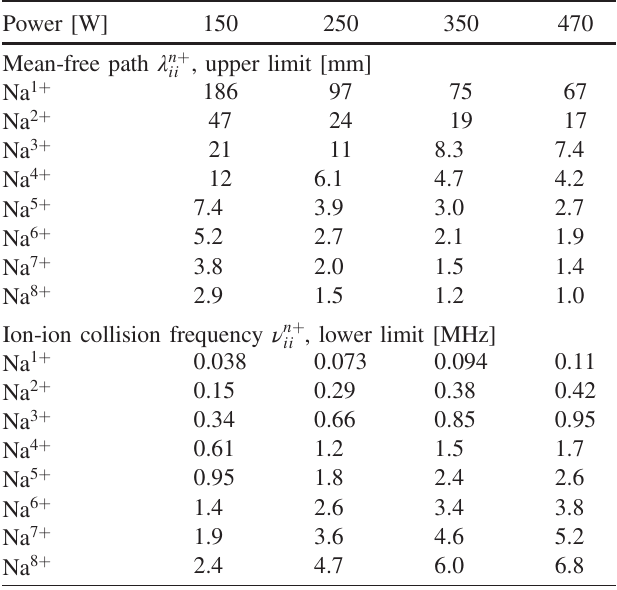
TABLE I. Breeding efficiencies (percentages) of low and high charge state 23 Na in helium plasma as a function of the micro- wave power. Δ V is optimized for Na 6 þ at each power.